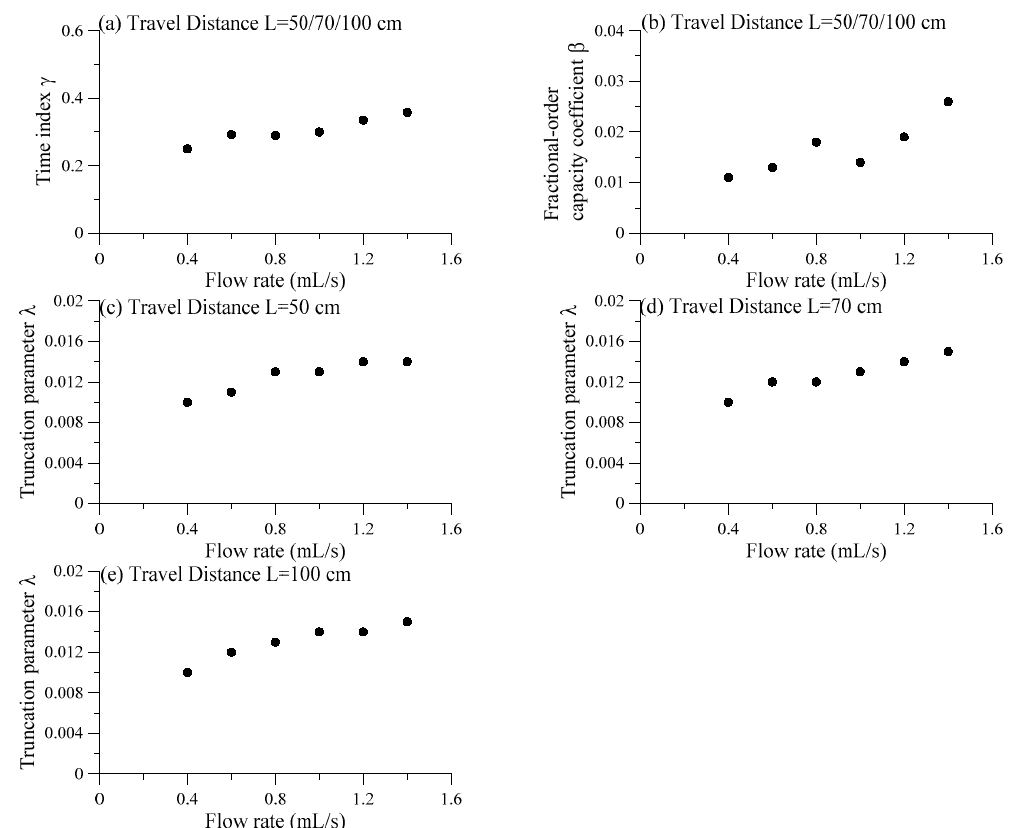
Figure 6. The tt-fADE model parameters change with the travel distance and flow rate.